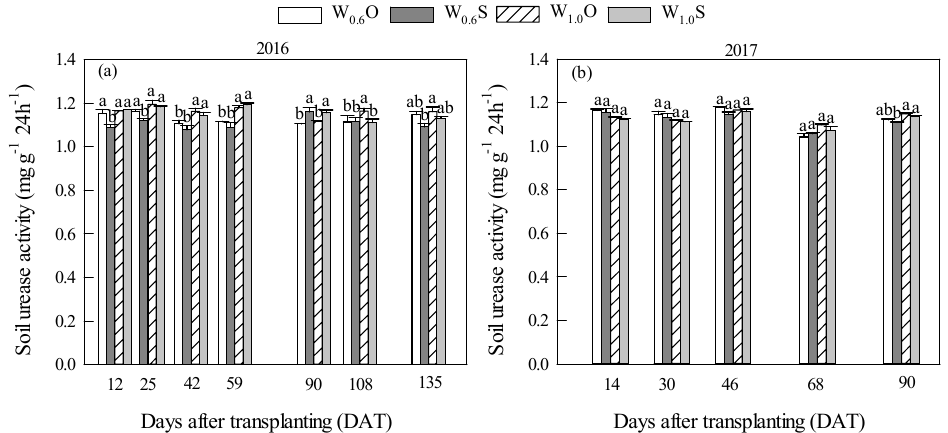
Figure 6. Variations of soil urease activity among treatments in the greenhouse tomato-growing seasons of 2016 ( a ) and 2017 ( b ).